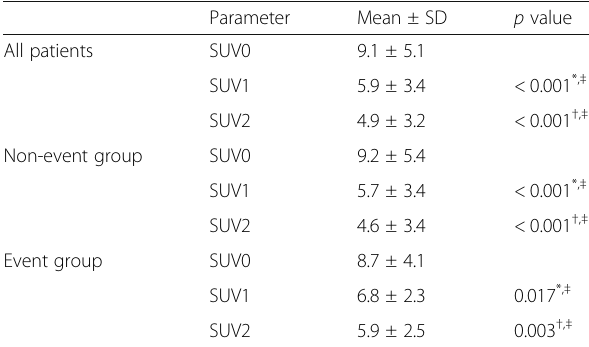
Table 2 SUV max at before, during, and after neoadjuvant chemotherapy depending on the event Parameter Mean ± SD p value All